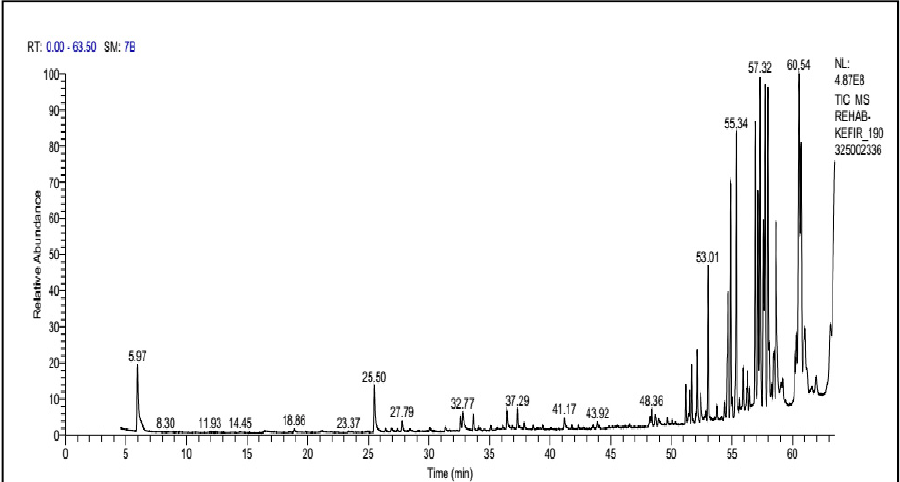
Figure 1. GC-MS analysis of KB.